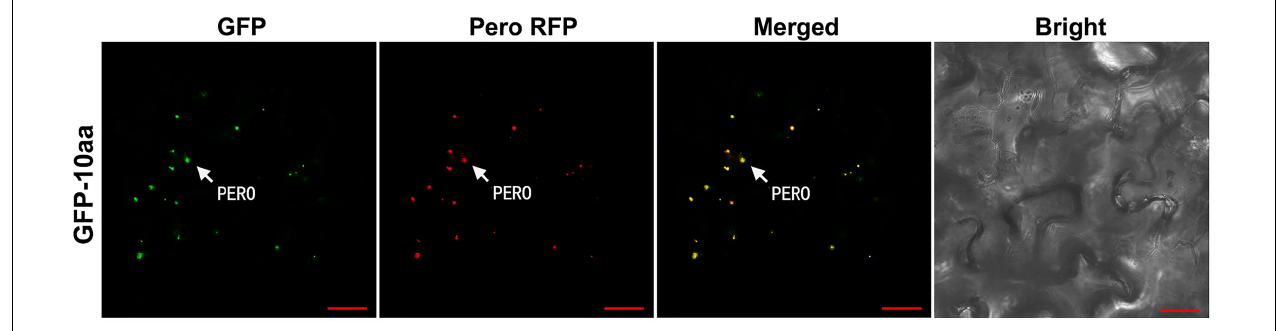
FIGURE 4 | Confocal fluorescence scanning of GFP guided by the C-terminal decapeptide of AcCATPO. See Figure 2 legend for tobacco leaf agro-infiltrating transformation and fluorescence detection, except the leaf cells were stained, before the detection, with MitoTracker Deep Red FM according to the manufacturer’s instruction. PERO, peroxisome; Pero RFP, Peroxisome-localized RFP marker; Bar = 20 µ